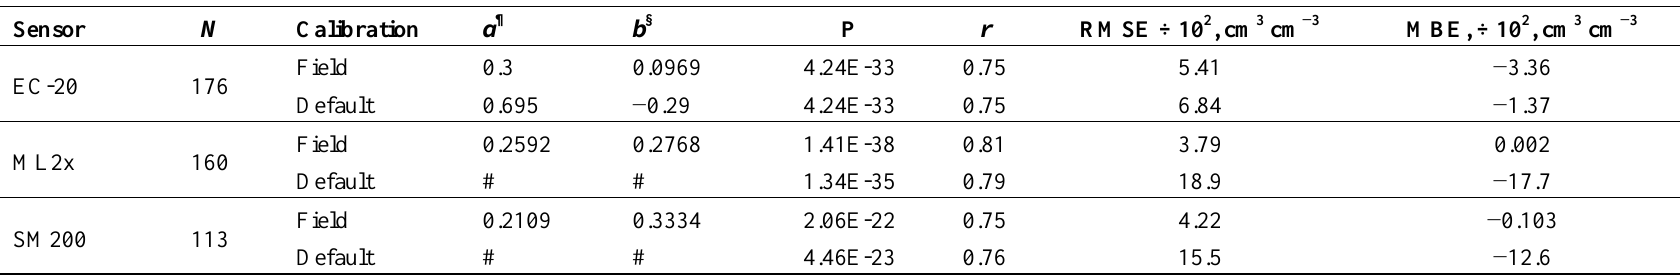
Table 6. Regression parameters of watershed-specific field calibration equations and accuracy indicators (RMSE; root mean squared error and MBE; mean bias error) of field and default